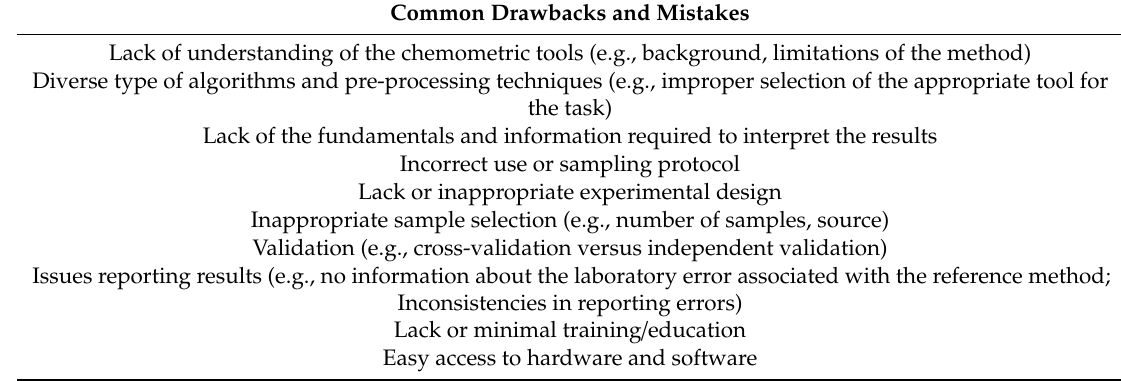
Table 2. Summary of common drawbacks and mistakes encountered during the application of chemometrics in food science, research, and